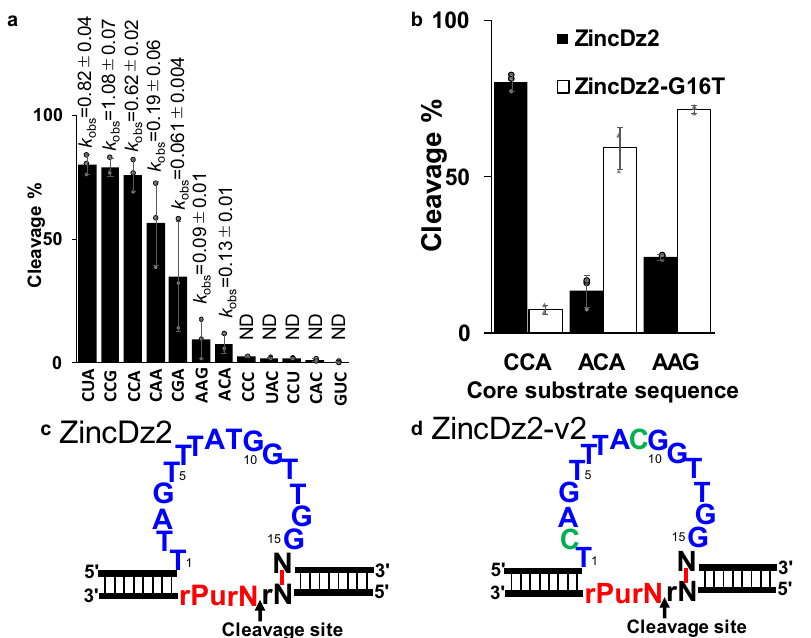
Fig. 4 Substrate sequence speci fi city of ZincDz2. a Twelve substrates that have different core RNA sequences were cleaved by ZincDz2. b ZincDz2-G16T mutant, which was designed to form a base pair between the 1st rA in the core substrate region and 16th T in the core catalytic region, can recover the cleavage activities for the substrates with “ 5 ′ -rArCrA-3 ′ ” and “ 5 ′ -rArArG3 ′ ” . The error bars show the SD of three independent experiments. c A diagram summarizing the results of the sequence speci fi city of ZincDz2. The rede fi ned catalytic core region and core substrate region are represented in blue and red, respectively. d The predicted secondary structure of highly active mutant, ZincDz2-v2. The mutated bases are represented in green.